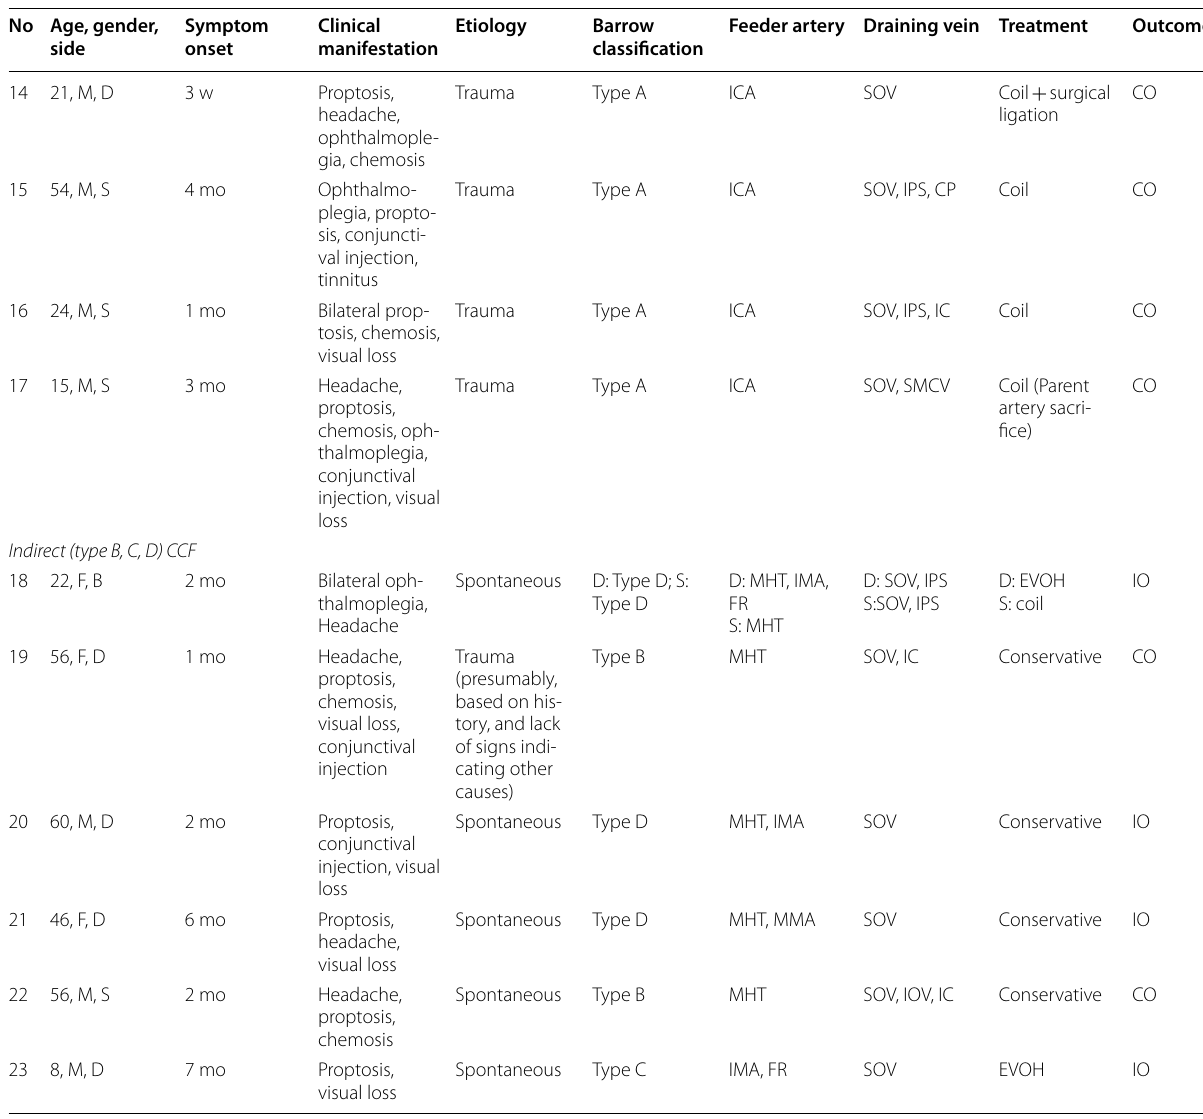
CCF cases. The most common site of rupture is in the proximal vertical segment and the horizontal portion of cavernous ICA [8]. In indirect CCF, male and female were affected equally (male:female ratio 1:1), and most Anterior Posterior Inferior Superior cases were spontaneous. All of our patients had orbital or neuro-ophthalmologic sign or symptoms. Proptosis was the most common sign and is the main chief complaint among our patients. Other clinical manifestations include headache, chemo- sis, visual loss, ophthalmoplegia, conjunctival injection,